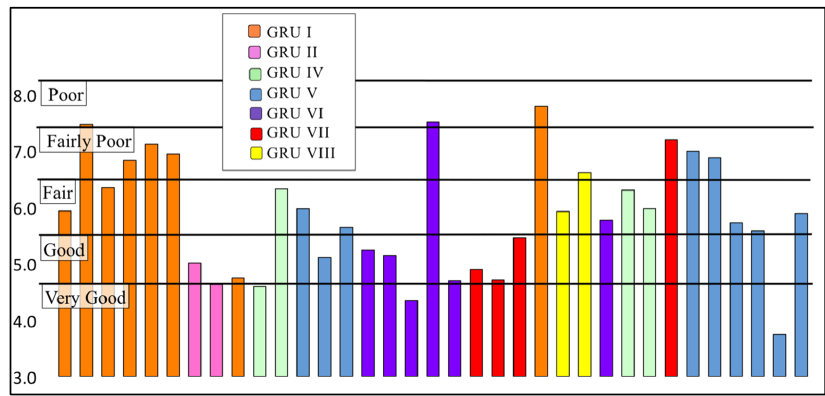
Figure 7. Biotic index scores for each sampling site, displayed in river order, for the Qu’Appelle River. Bar-colours indicate the GRU each site is located in.